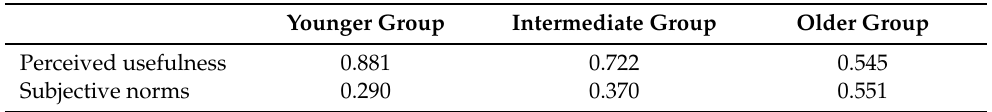
Table 7. Pearson’s coefficients for the correlations between perceived usefulness and ITO and between subjective norms and ITO for the three age-range